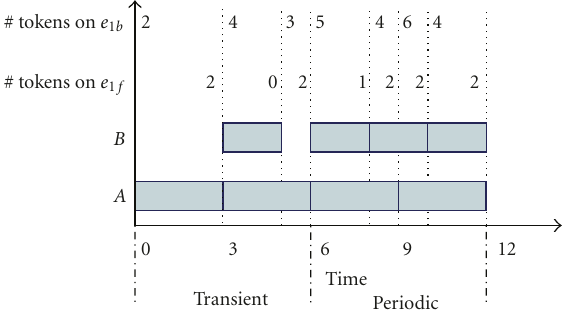
Figure 11: Schedule and life-time analysis of the bu ff er